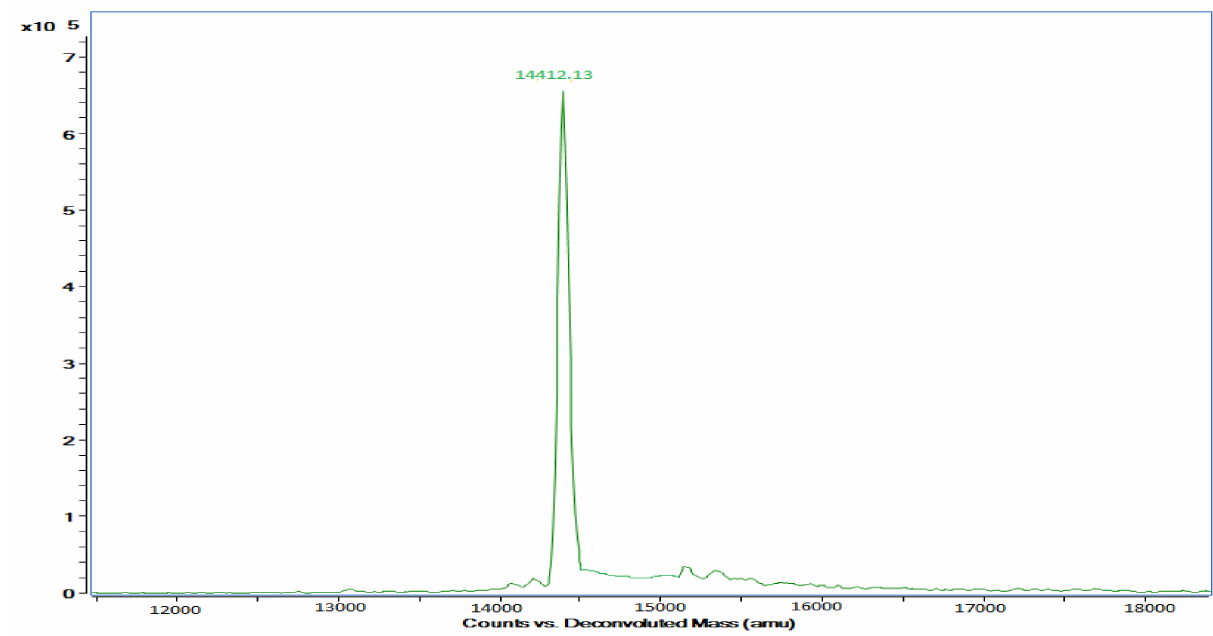
Figure 4. Deconvoluted mass spectrum of bacterial pectinase from Bacillus subtilis